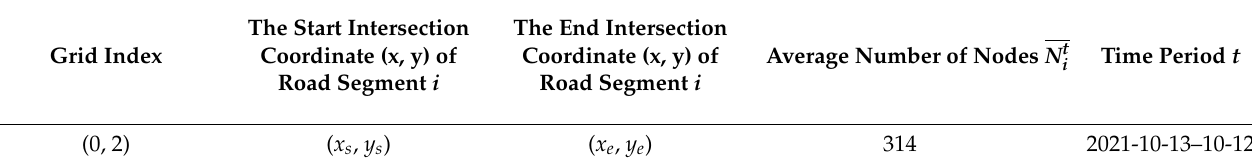
Table 4. Average number of nodes of road segment i in period t